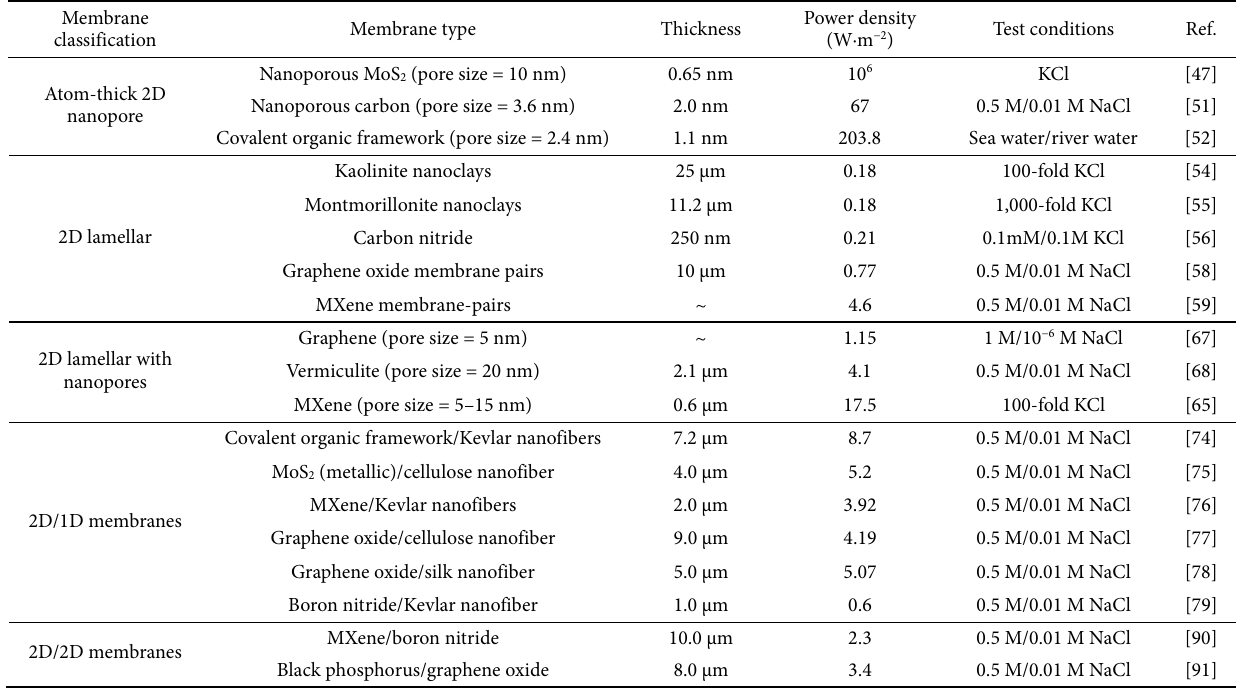
Table 1 Performance comparison of 2D membranes for osmotic power generation Membrane